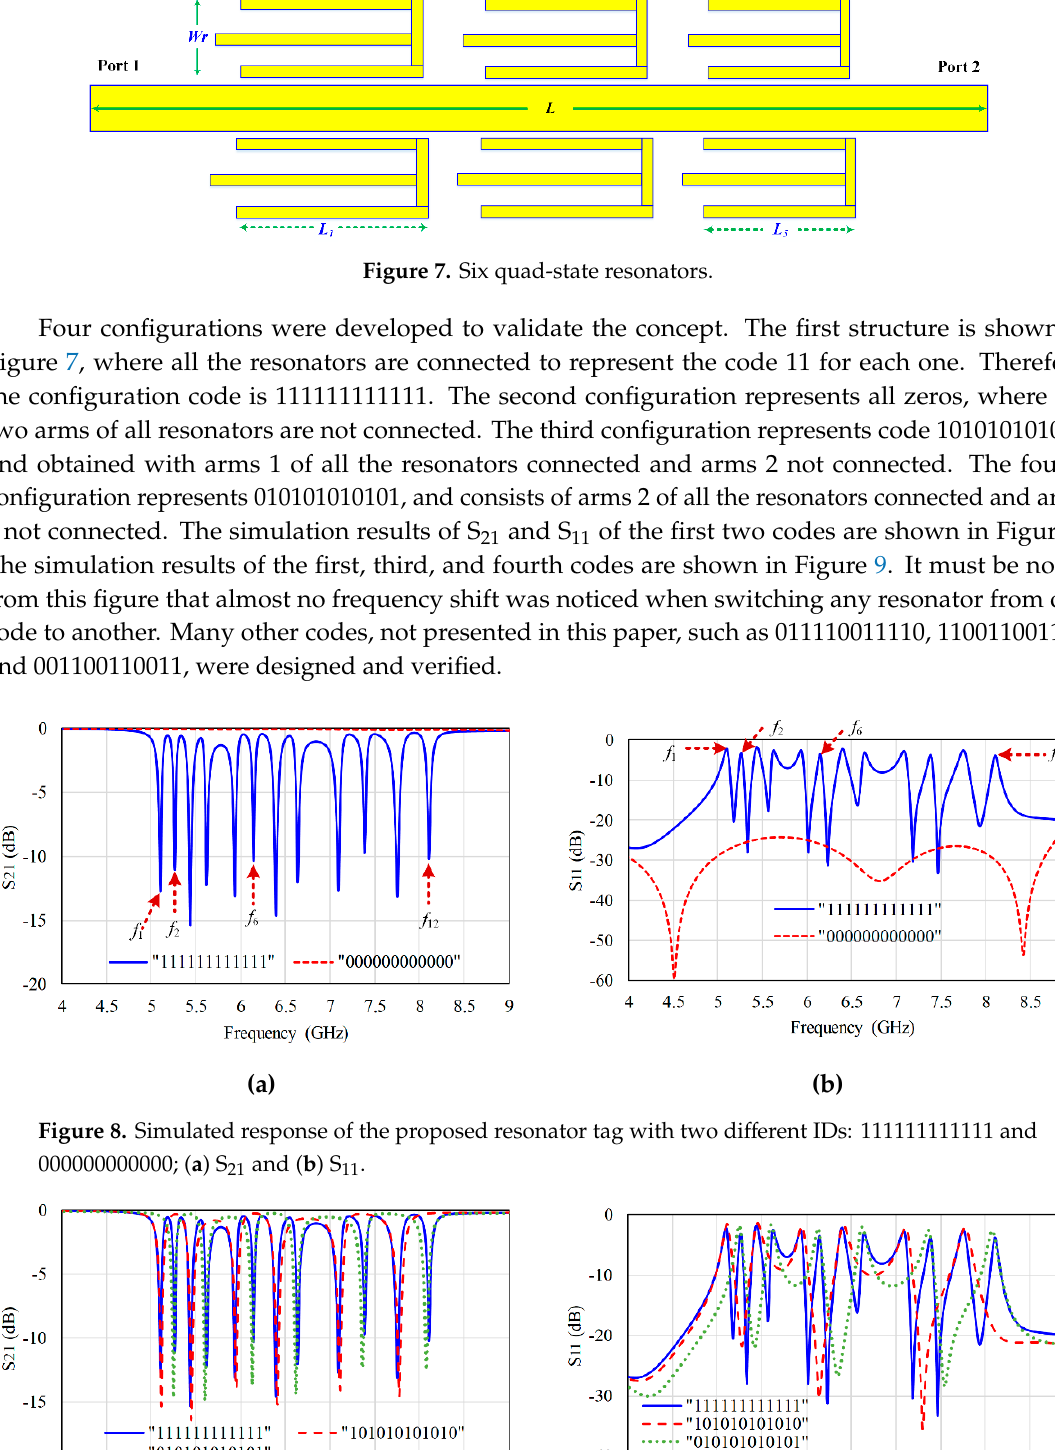
Figure 9. Simulated results of the proposed tag with three different codes: 111111111111, 101010101010, and 010101010101; ( a ) S 21 and ( b ) S 11 .